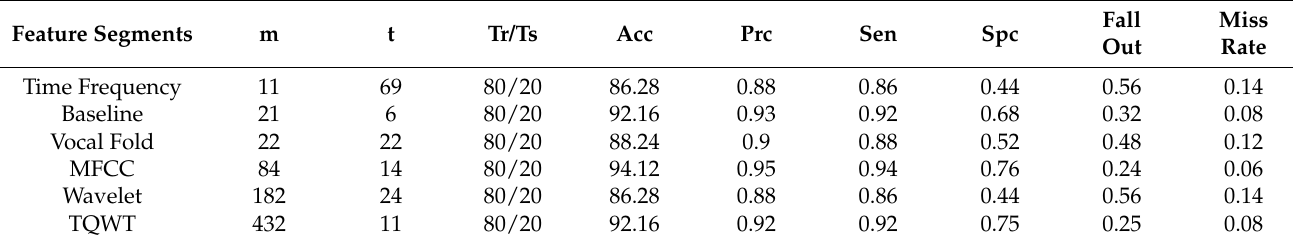
Table 7. Maximum performance received for ForestPA classifier with minimum number of decision trees on primary and derived features of Istanbul acoustic